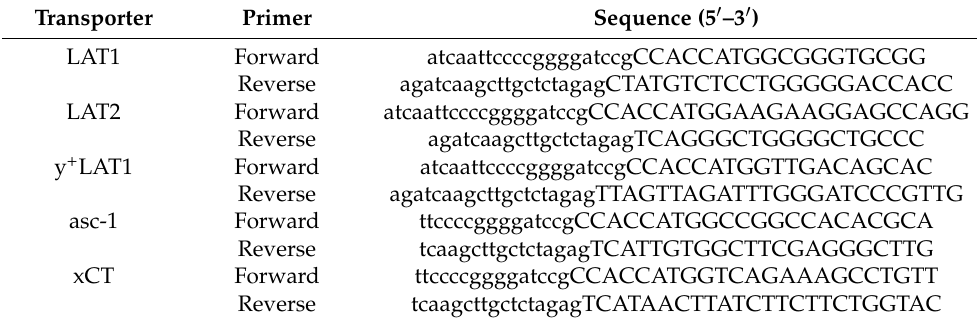
Table 1. Primers used for Gibson assembly. Lower-case letters denote bases homologous with pGHJ cleaved at the EcoRI site and upper-case letters complement the start and end of the coding sequence of the transporter. Where applicable, the Kozak sequence was designed to match with the optimal consensus